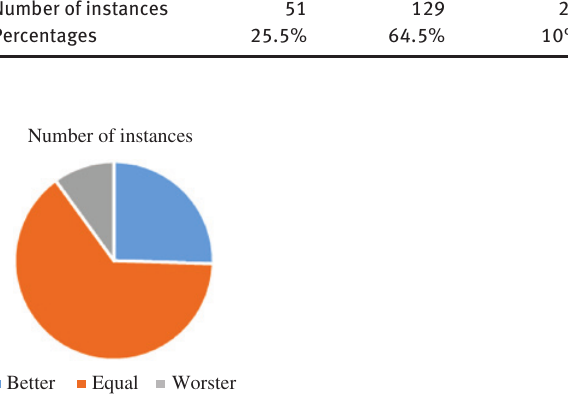
Figure 3: Graphical Representation of